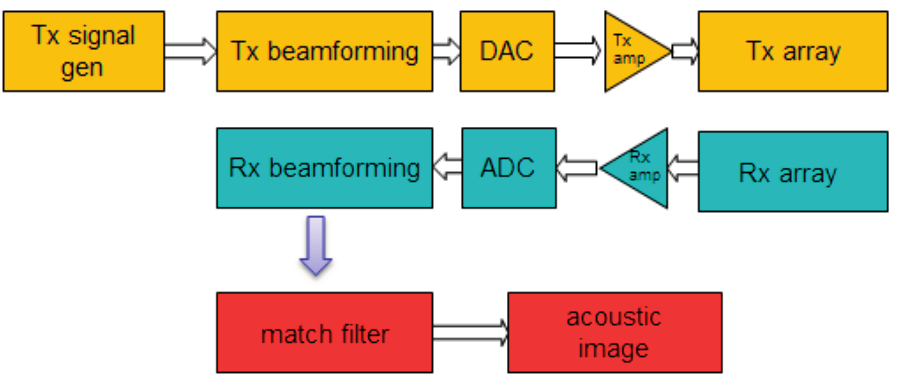
Figure 5. Acquisition system block